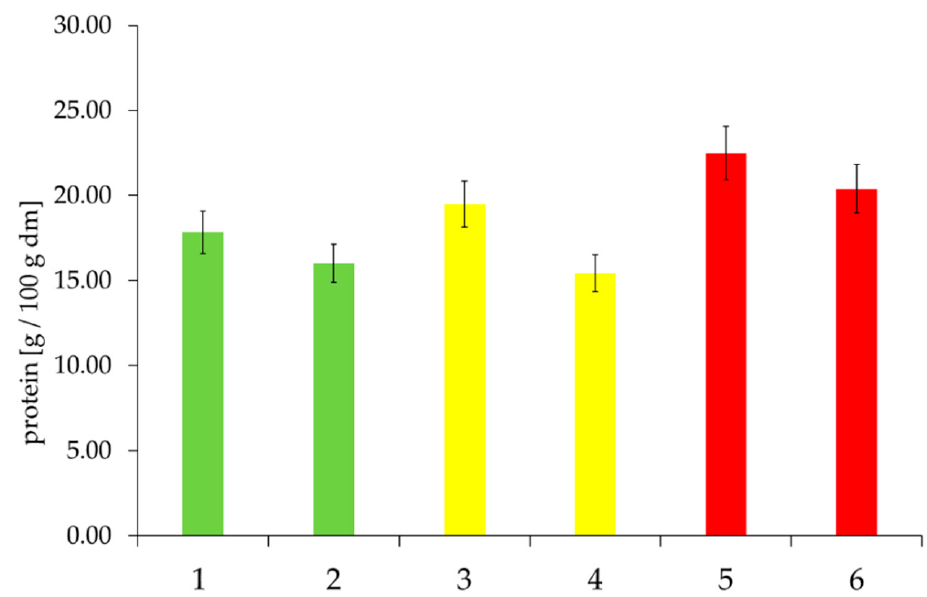
Figure 10. Protein content in the gel phases of the selected samples, depending on “good” to “medium” to “poor” baking quality and the corresponding falling number (FN) within the individual baking quality classes (here: first samples were always assigned the lower FN and second samples the higher FN). Sample description: see Table 1. Bars represent the mean value of two replicates; error bars represent the confidence interval.